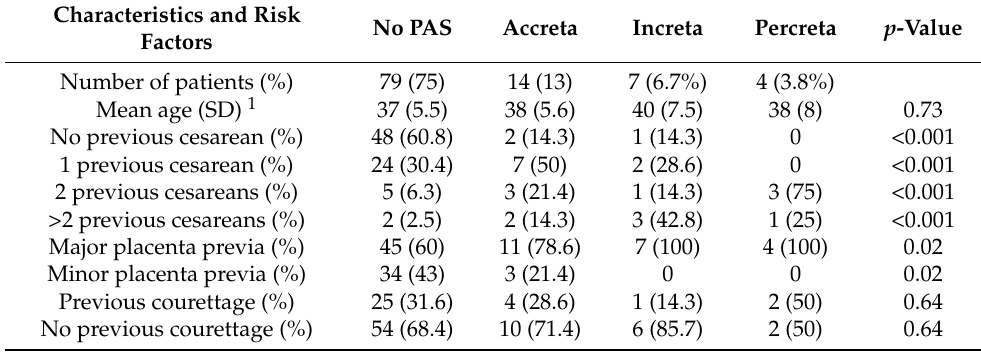
Table 1. Distribution of patients’ characteristics according to PAS severity groups.